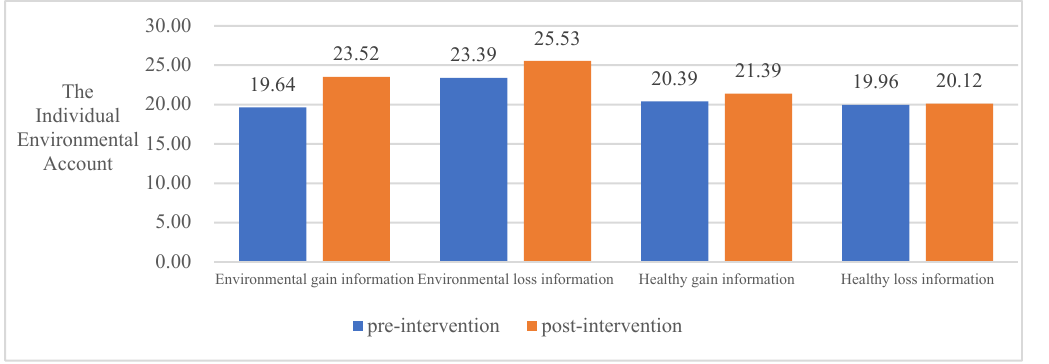
Figure 3. The impact of different information frameworks on the Individual Environmental Account.